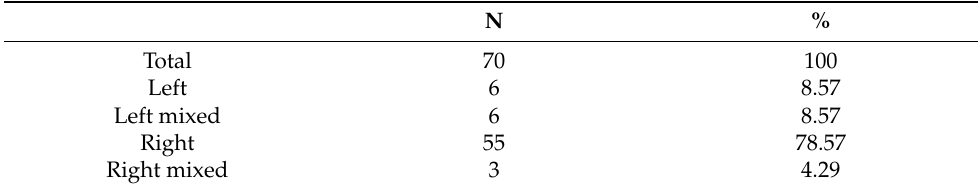
Table 1. Distribution of handedness in our study